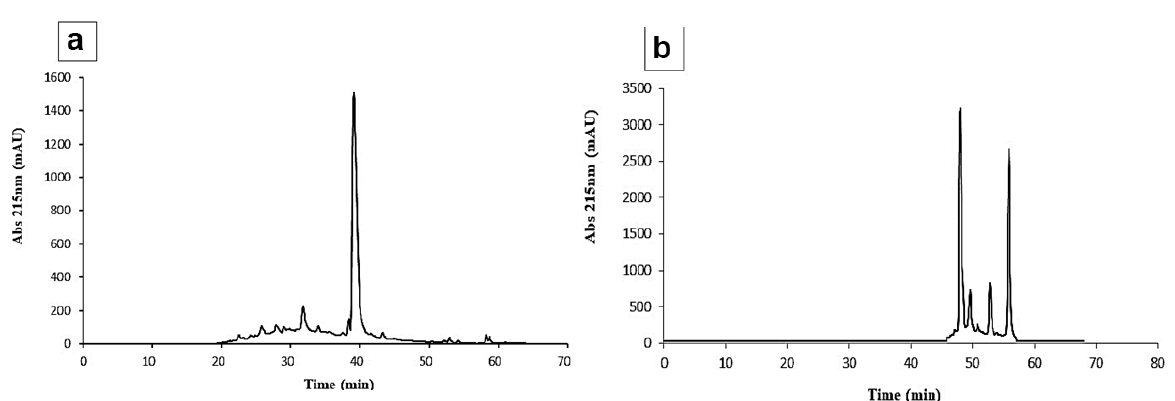
Figure 7. HPLC chromatogram profile of azocasein degradation process using a protease purified from A. sydowii . (a) HPLC profile of Azocasein purchased from Sigma; (b) HPLC profile of Azocasein hydrolysis using a protease purified through the optimum